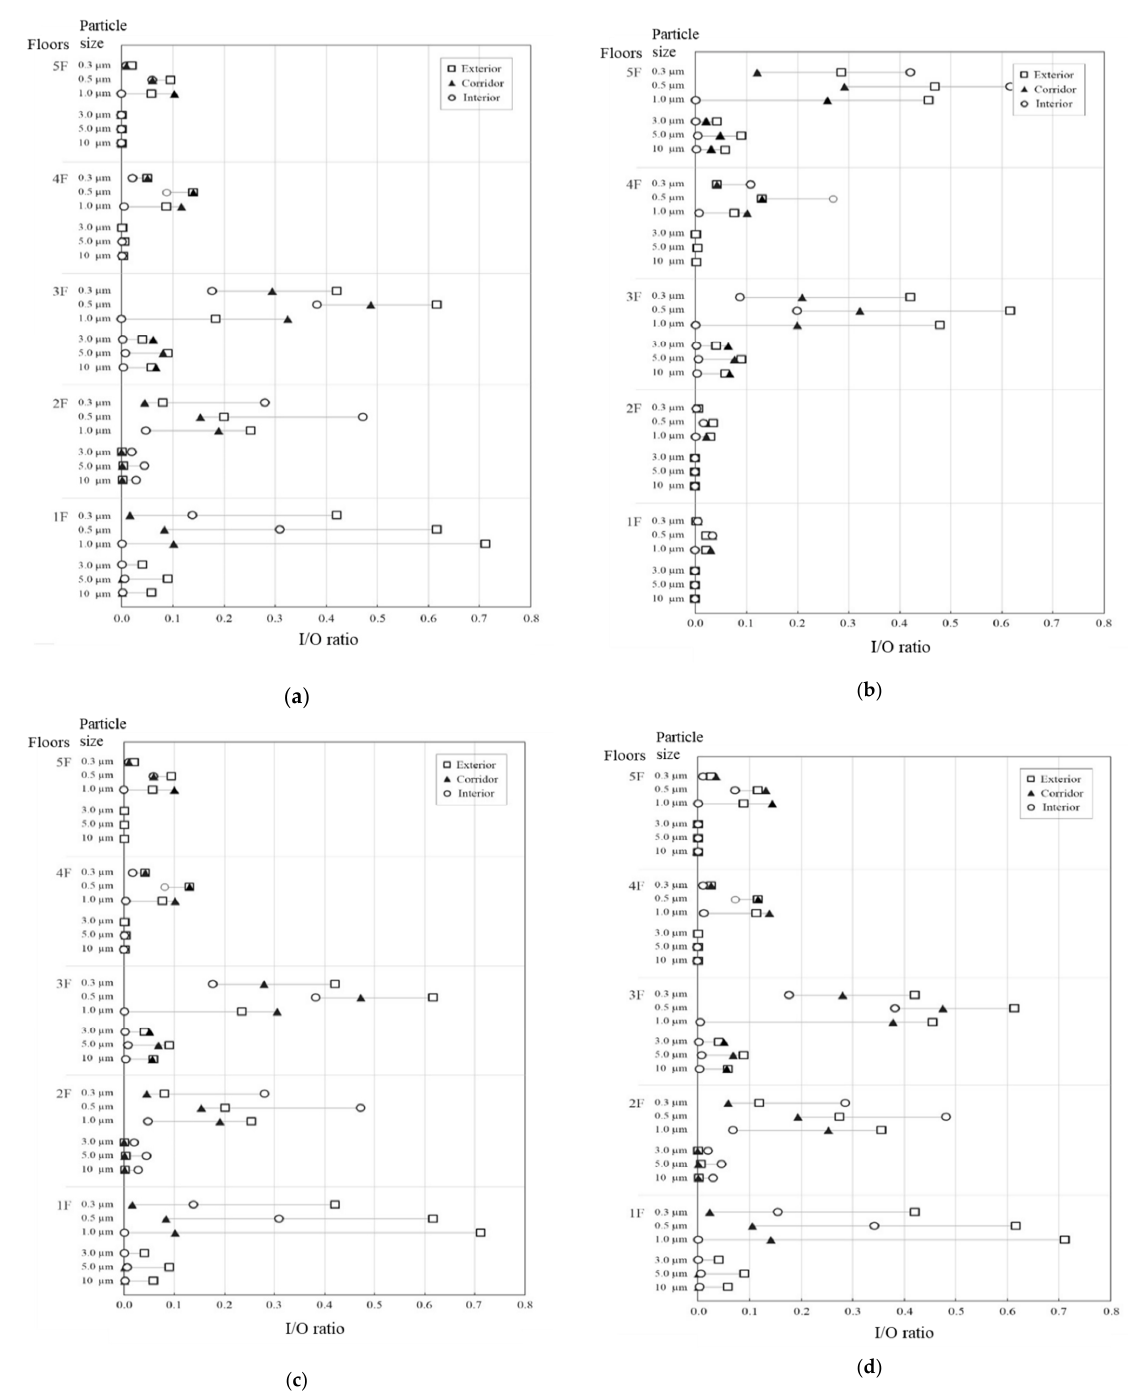
Figure 10. I/O ratio distribution profiles for the reference building: ( a ) case 1, spring; ( b ) case 2, summer; ( c ) case 3, autumn; ( d ) case 4, winter. In all the seasons, the I/O ratios were larger for the fine particles (0.3, 0.5, and 1.0 μ m) than for the coarse particles (3.0, 5.0, and 10.0 μ m). This was because the coarse particles were affected by the small penetration coefficient and large deposition coefficient